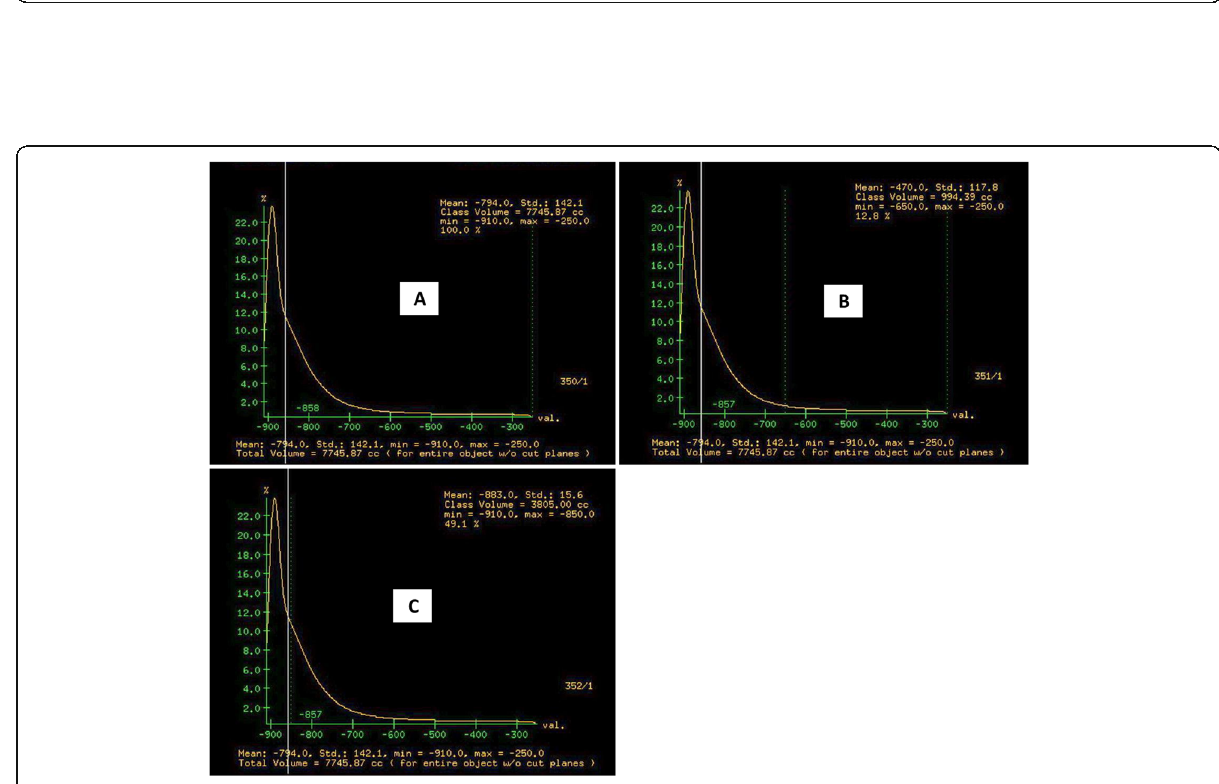
Fig. 5 CT histogram analysis a showing total lung volume (TLV) and mean lung density (MLD) between threshold densities − 250 and − 910 HU, b showing the percentage of the lung occupied by high attenuation areas (HAAs %) about 12.8%, and c showing the percentage of lung occupied by low attenuation areas (LAAs %) about